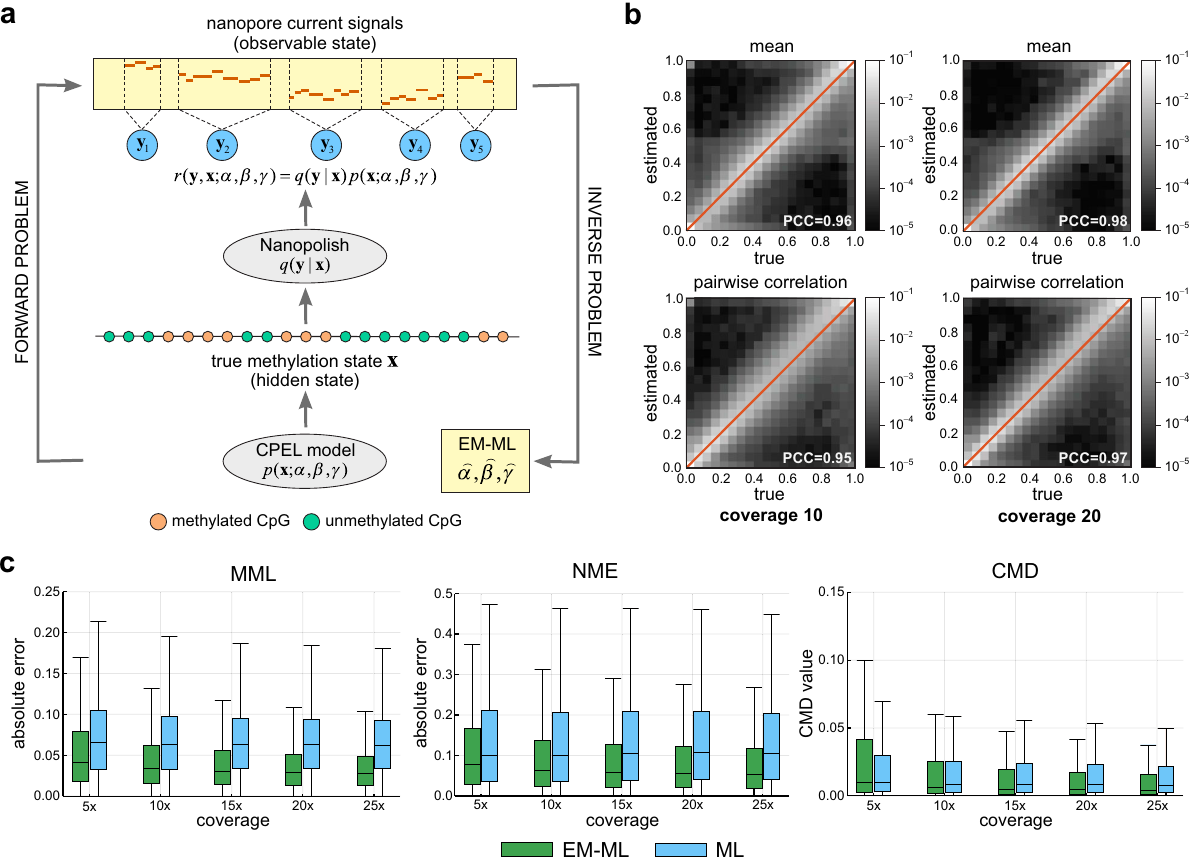
Figure 1. The CpelNano method and simulated performance evaluation results. ( a ) To consider nanopore noise, CpelNano employs a hidden Markov model (HMM) approach, which treats the true methylation state xxx over an estimation region of the genome as a hidden state that is observed indirectly through a state yyy of nanopore current signals. It then models the hidden state using a parametric correlated potential landscape model (CPEL) p ( xxx ; α , β , γ) and addresses the forward problem of modeling the relationship between the observable and hidden methylation states using a data-generative model r ( yyy , xxx ; α , β , γ) = q ( yyy | xxx ) p ( xxx ; α , β , γ) , which is expressed in terms of the CPEL model p ( xxx ; α , β , γ) and emission probabilities q ( yyy | xxx ) computed using (cid:31) β Nanopolish 4 . Finally, it solves the inverse problem of estimating values (cid:31) α , , and (cid:31) γ for the unknown parameters of the CPEL model of the hidden methylation state from available nanopore data using an expectation- maximization based maximum-likelihood (EM-ML) approach. ( b ) Binned joined probability distributions and associated Pearson correlation coefficient (PCC) values between estimated and true means and pairwise correlations at individual CpG sites, obtained by using a simulation-based approach (Fig. S4). Results are shown for nanopore noise with standard deviation sd = 3 and data coverages of 10 × and 20 ×. A lighter region indicates a higher probability of association between estimated and true values. ( c ) Boxplots depicting distributions of absolute errors over analysis regions between estimated and true mean methylation level (MML) and normalized methylation entropy (NME) values, as well as distributions of coefficient of methylation divergence (CMD) values between the estimated and the true probability distributions of methylation. These quantities were computed by the EM-based maximum-likelihood (EM-ML) approach of CpelNano (green), as well as by fitting the CPEL model directly to the methylation calls made by Nanopolish 4 using maximum-likelihood (ML; blue). Results are shown for nanopore noise with standard deviation sd = 3 and data coverages of 5 ×, 10 ×, 15 ×, 20 ×, and 25 ×. Center line of box: median value; box bounds: 25th and 75th percentiles; lower whisker: larger of minimum value and 25th percentile minus 1.5 × interquartile range; upper whisker: smaller of maximum value and 75th percentile plus 1.5 × interquartile